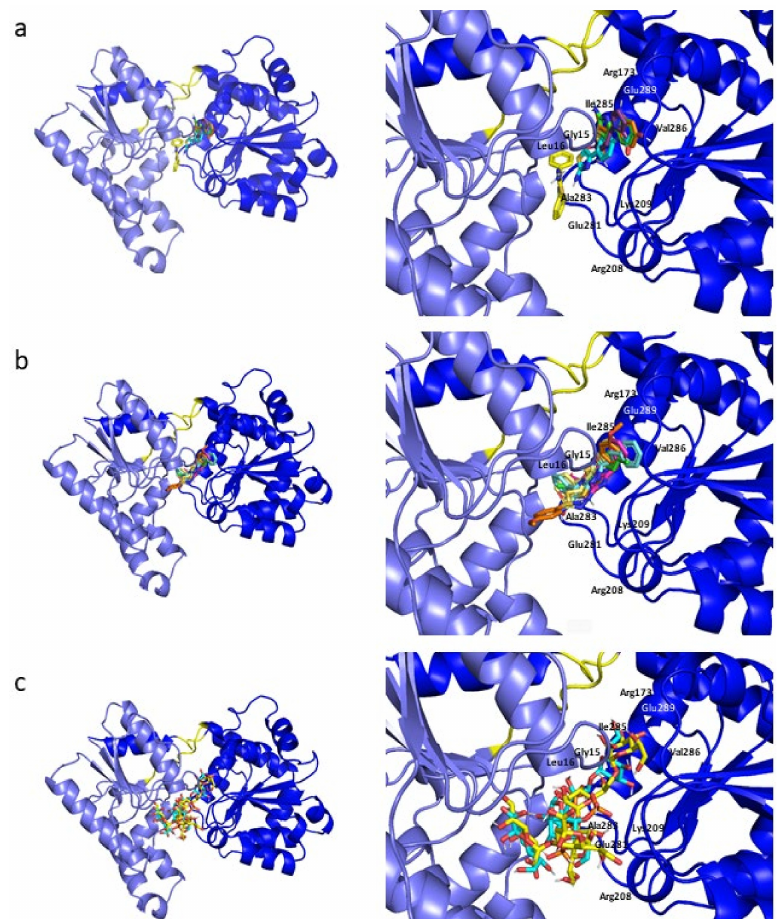
Figure 5. Docking poses of the representative ligands of libraries ( a ) A, ( b ) B and ( c ) C. On the right, a close-up of WaaG binding pocket showing the most relevant amino acids surrounding the ligands structures. ( a ) compound A1 in green, A7 in blue marine, A9 in yellow, A14 in orange and A16 in violet. ( b ) compound B3d in blue marine, B16 in light yellow, B22 in fuchsia, B26 in orange and B33 in green. ( c ) compound C6 in blue marine and C10 in